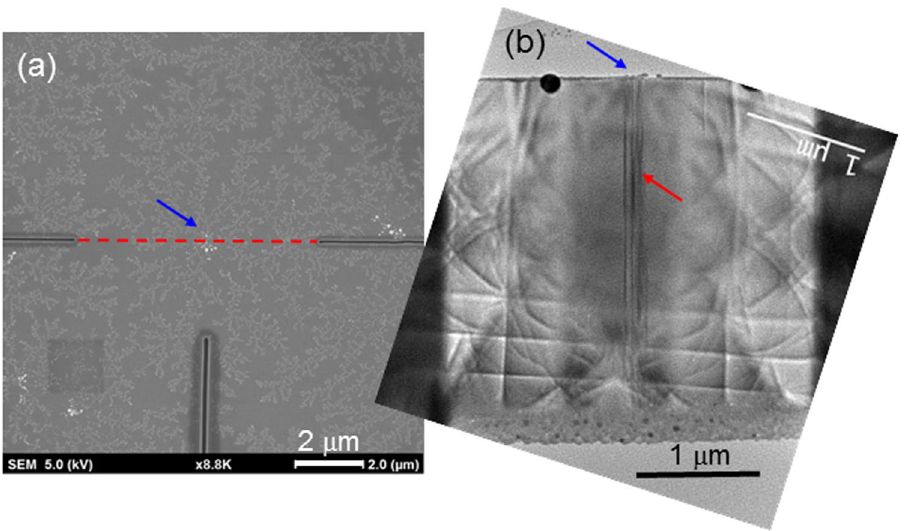
Figure 12. ( a ) SEM image of an Ag NP sample with multiple BTs under FIB process for preparing a TEM specimen. ( b ) Cross-sectional TEM image right below a BT